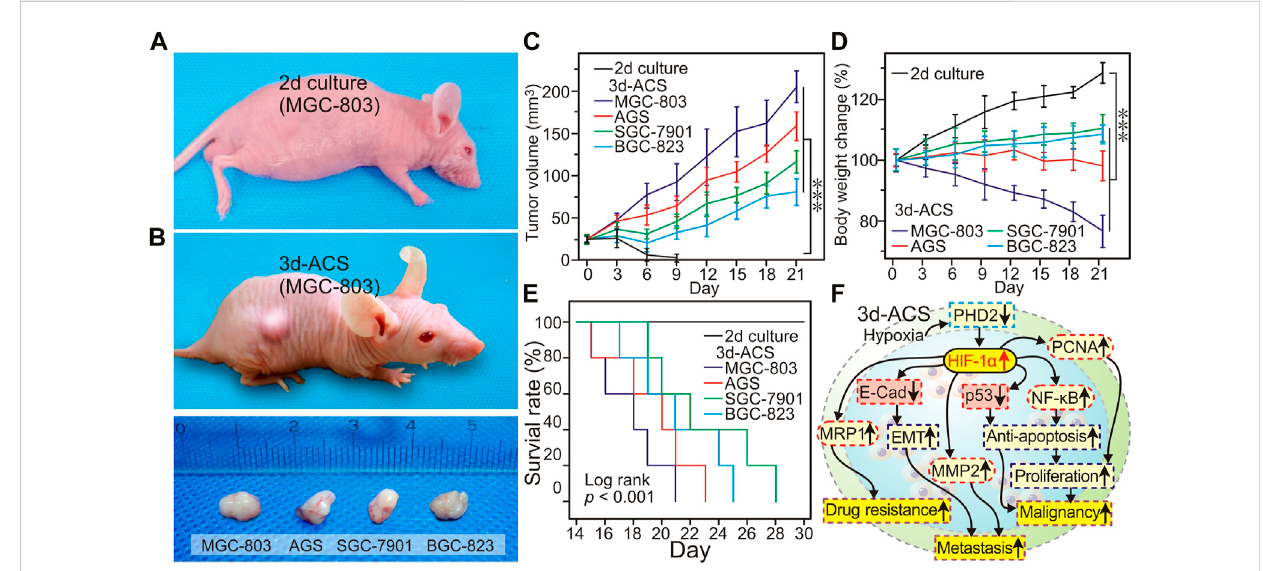
FIGURE 7 After inoculation in mice, the GC cell growth in the mouse model. (A) On day 21, with the same number of inoculation, the tumor morphology of MGC-803cellsculturedin2dand3d-ACS,thecellsculturedin2dfailedtoestablishtumorxenografts(uppanel). (B) Afterculturedin3d-ACS,the ex-vivo tumor morphology of 4 GC cell lines in mice on the day 21. (C) The body weight changes of mice with different cell line inoculation. (D) Tumor growth curveof3d-ACSxenografts( n =5foreach3d-ACSline). (E) Kaplan-Meiercurvesofmiceindifferentcelllineinoculation. (F) Themechanismsof3d- ACS hypoxia-induced malignancy of cancer cells. n = 5 per group, ***: p <